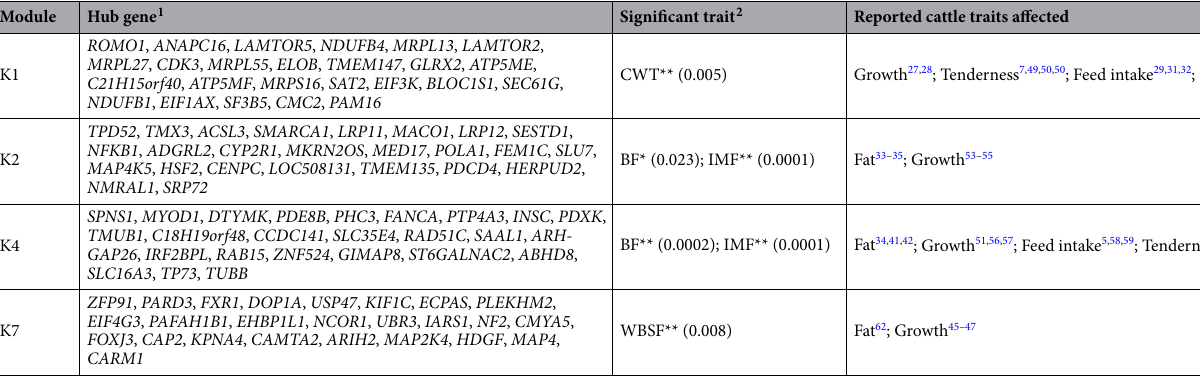
1 : Top 25 hub genes; Significant